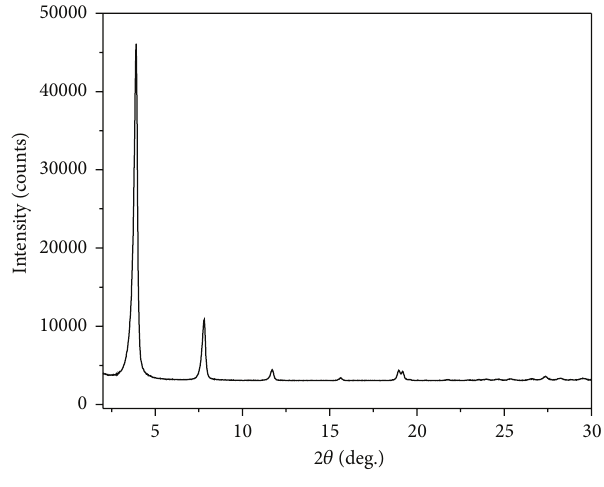
Figure 1: XRD pattern of